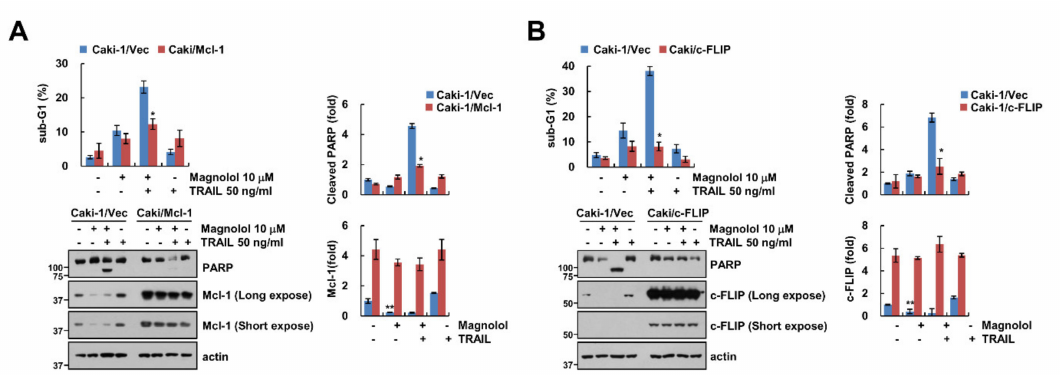
Figure 4. Overexpression of Mcl-1 and c-FLIP attenuated magnolol plus TRAIL-induced apoptosis. ( A , B ) Vector cells, Mcl-1- ( A ), and c-FLIP-overexpressing cells ( B ) were treated with 10 µ M magnolol alone, 50 ng / mL TRAIL alone or magnolol plus TRAIL for 24 h. The sub-G1 population and protein expression were detected using flow cytometry and Western blotting, respectively ( A , B ). The values in graph ( A , B ) represent the mean ± SD of three independent samples. * p < 0.01 compared to combined treatment with magnolol and TRAIL in Caki-1 / Vec. ** p < 0.01 compared to control.